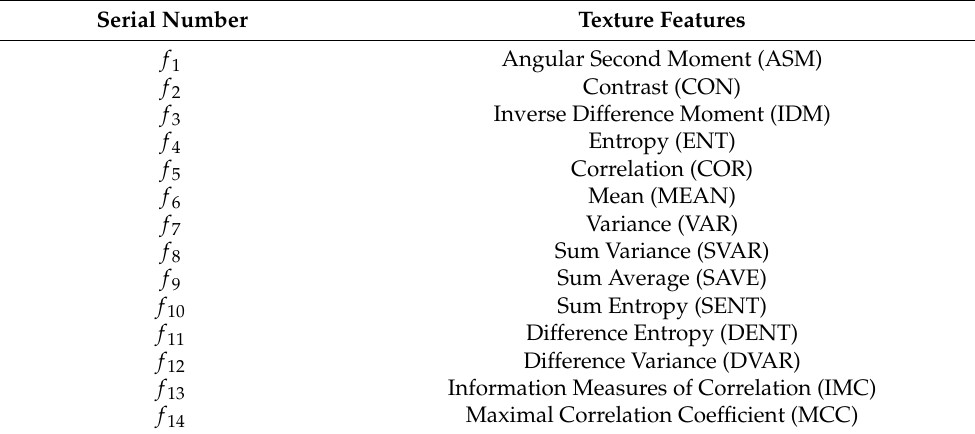
Table 1. The 14 texture features and their serial